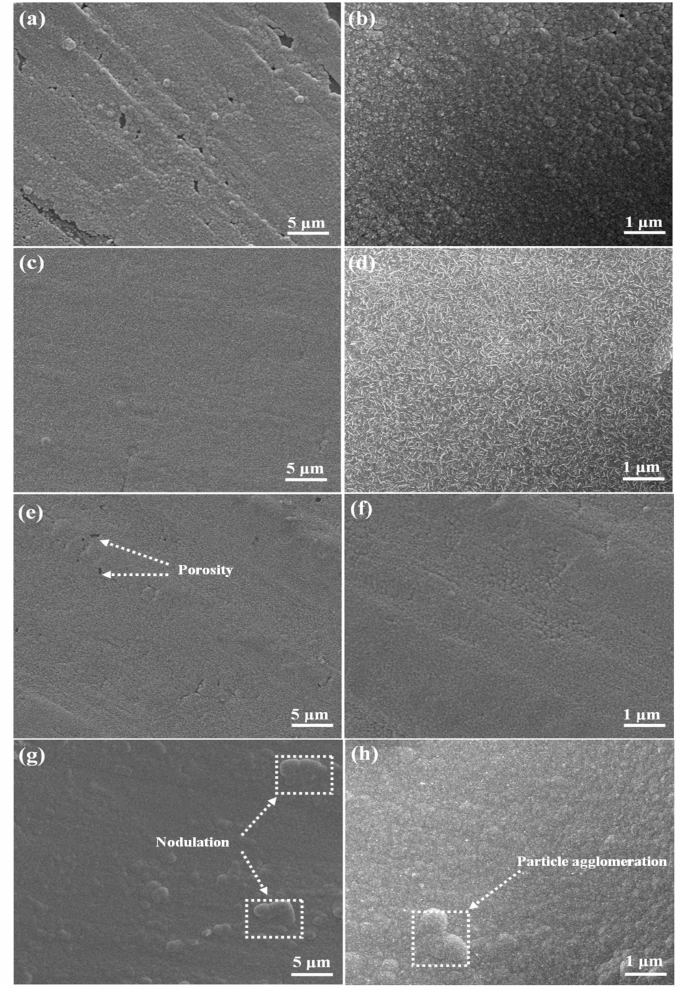
Figure 5. Scanning electron micrographs of nickel deposits with composite additives. ( a , b ) TU, ( c , d ) TU+ CTAC, ( e , f ) TU+ SDS, ( g , h ) TU +